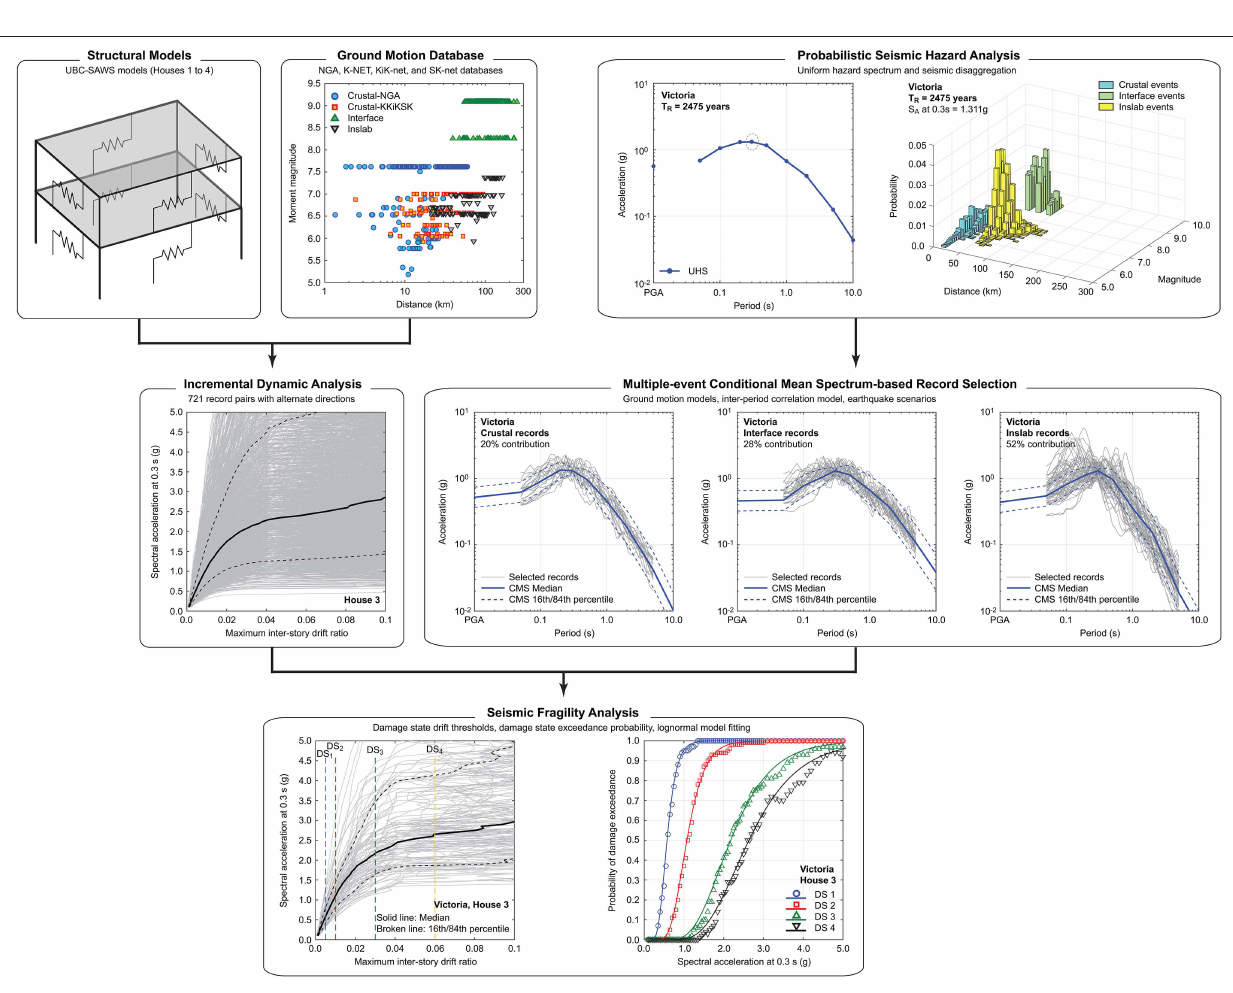
Frontiers in Built Environment |